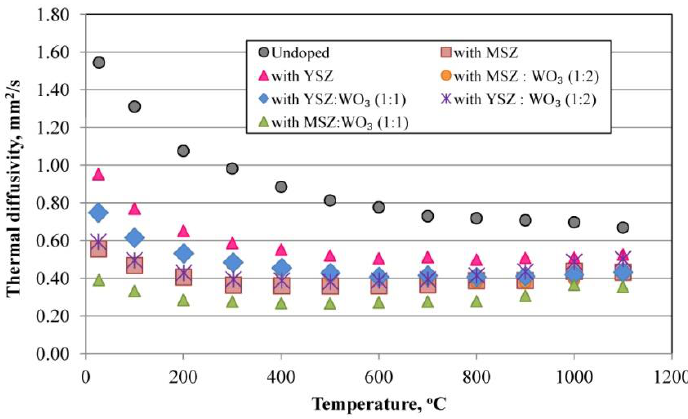
Figure 11. Thermal diffusivity of the samples.